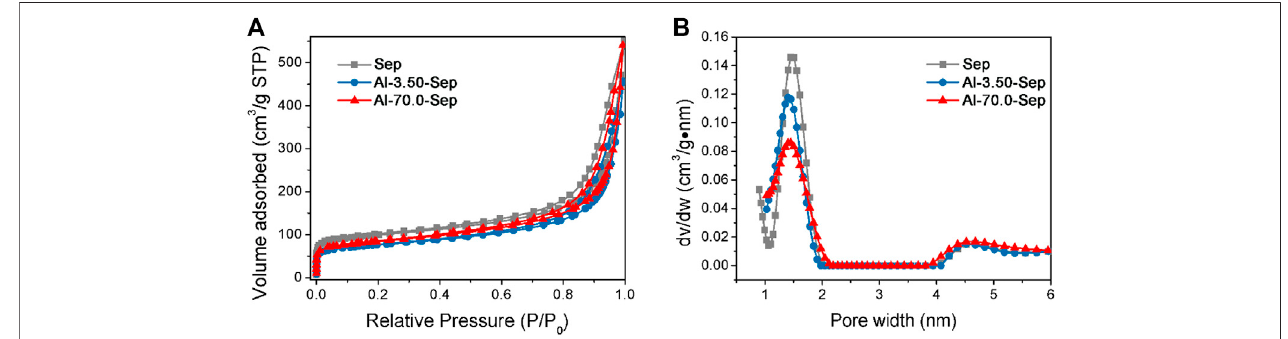
FIGURE 6 | The NH 3 -TPD curves after heating from 50 to 600 ° C of (A) Sep, (B) Al-0.00-Sep, (C) Al-3.50-Sep, (D) Al-7.00-Sep, and (E) Al-70.0-Sep. (F) The acid amounts of samples.